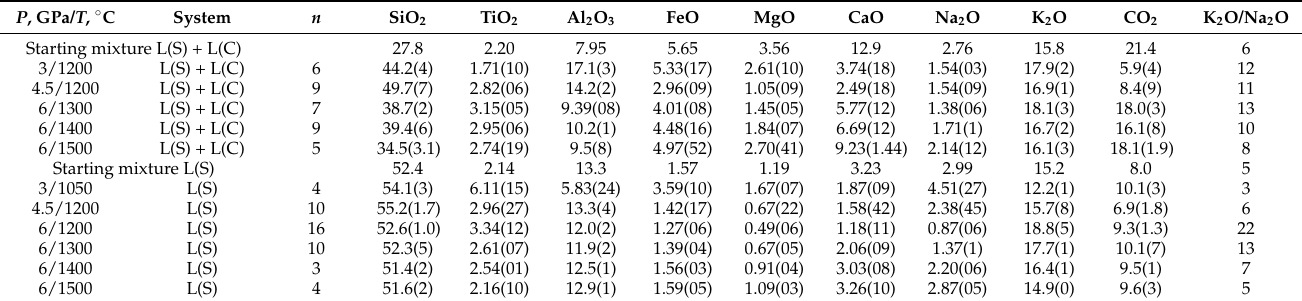
Table 8. Compositions (wt%) of silicate melt.